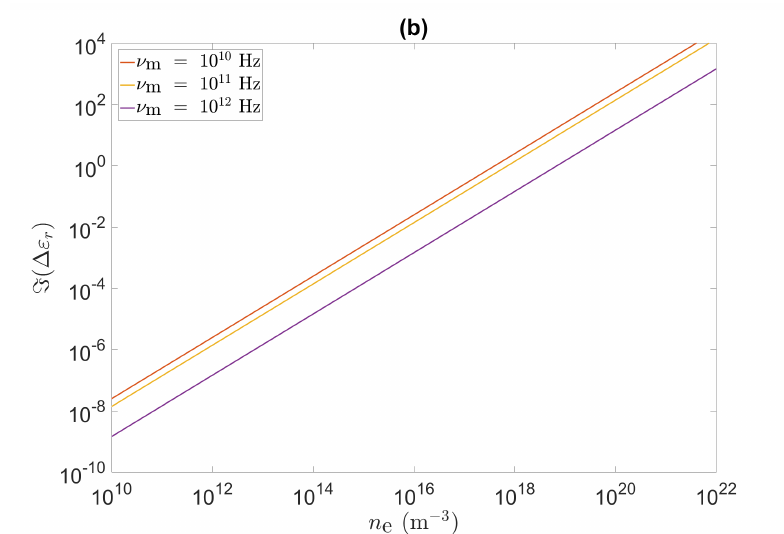
Figure 3. The change in the ( a ) real and ( b ) imaginary part of the relative permittivity of a plasma as a function of the electron density for four collision frequencies. The imaginary part of the permittivity is zero when the electrons do not collide and for this reason there is no change in the imaginary part of the permittivity for ν m = 0